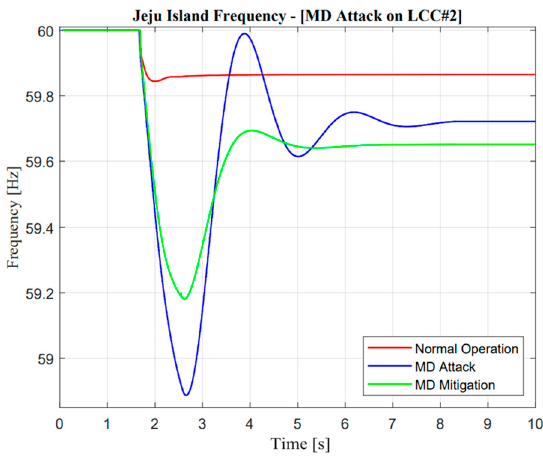
Figure 23. VSC active power response in the missing data attack operation.